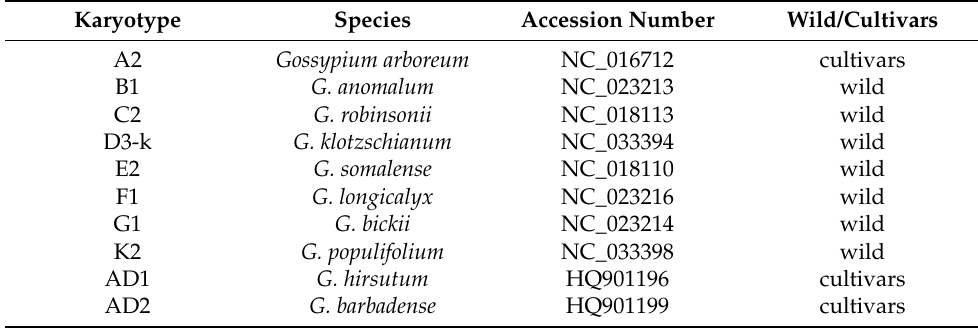
Table 1. Gossypium species information in the study. Karyotype Species Accession Number